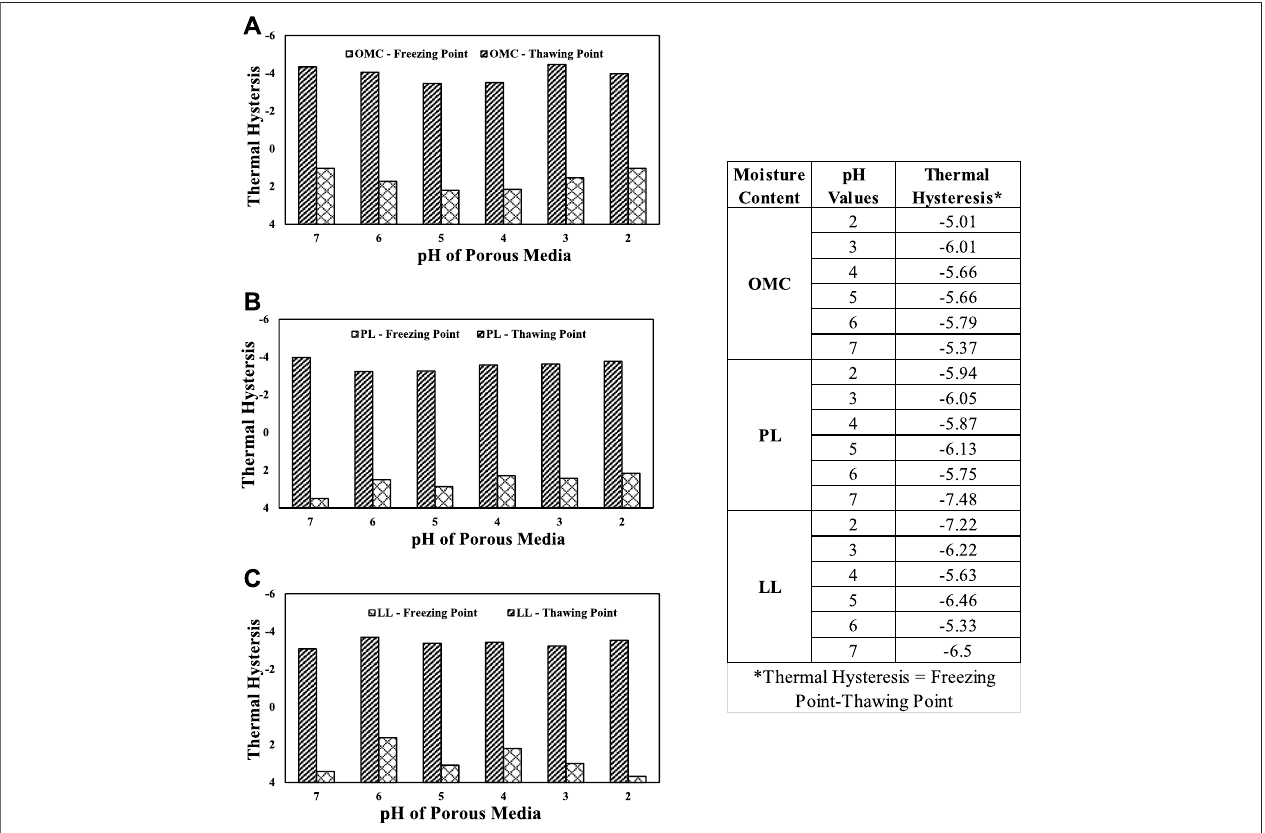
FIGURE 6 | Thermal hysteresis plots of elastic silt with different pH values and moisture contents: (A) plastic limit; (B) OMC; (C) LL.